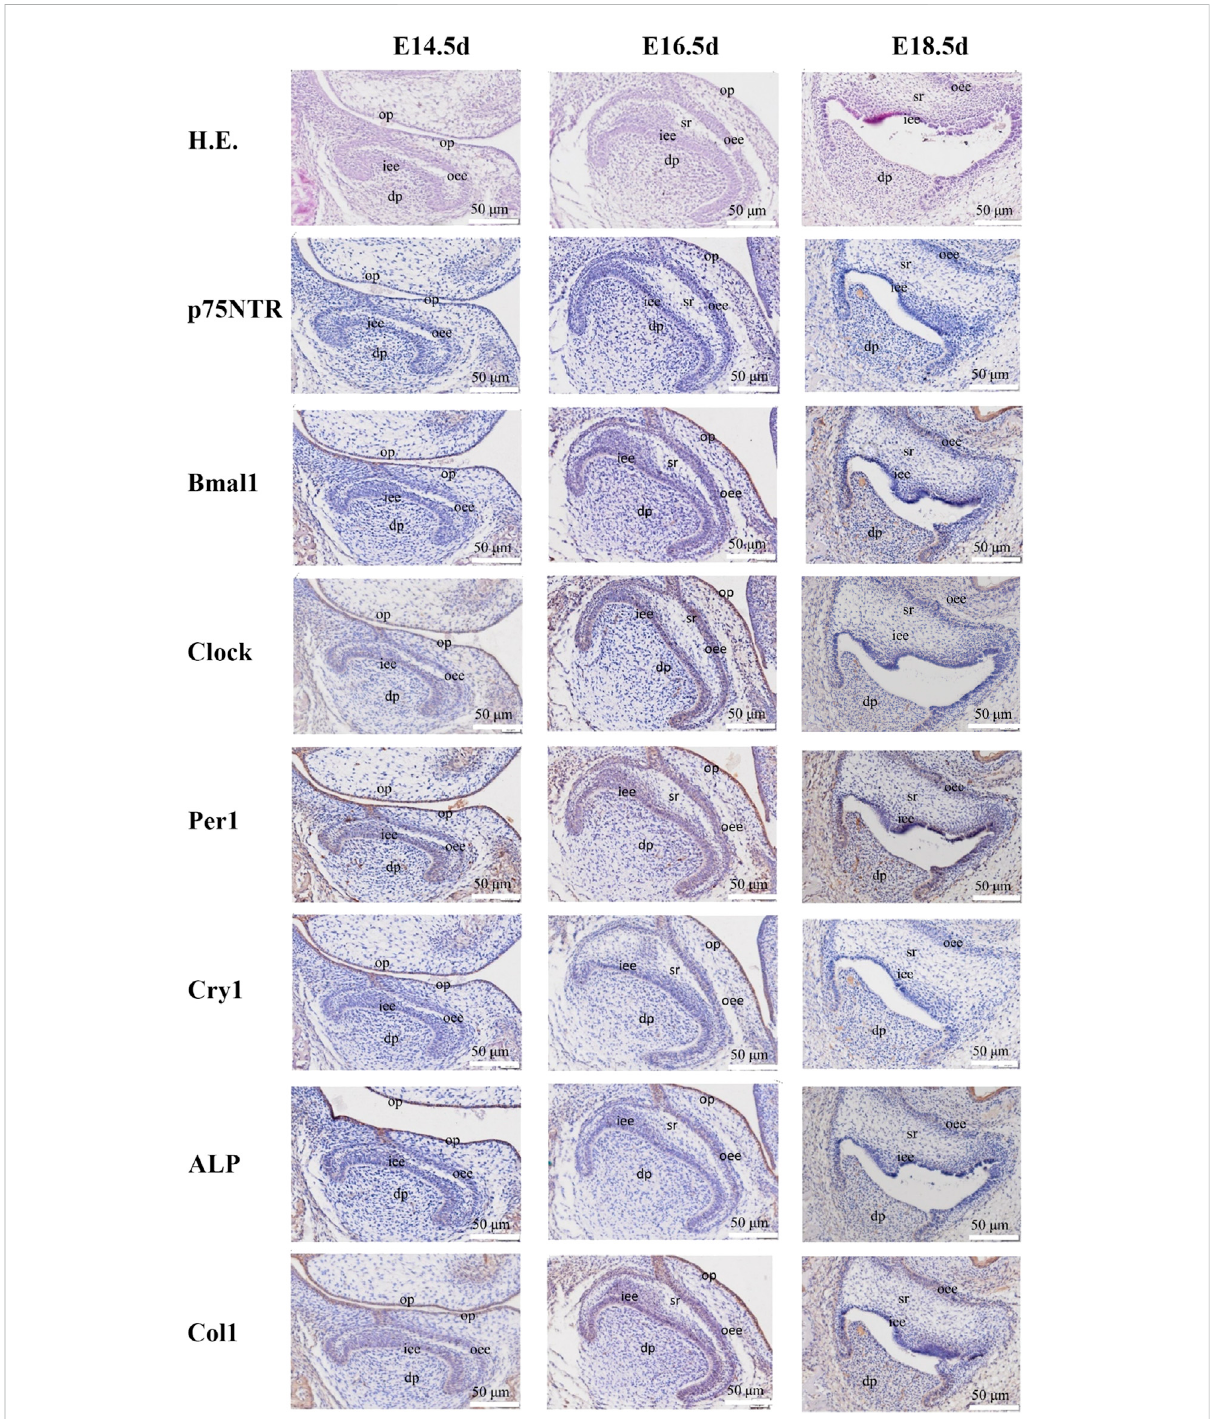
FIGURE 1 The images of H.E. staining and immunohistochemistry staining for prenatal rat dental germs. H.E. staining demonstrated that the rat dental germs entered the early cap stage at E14.5 d, the cap stage and early bell stage at E16.5 d, and the bell stage at E18.5 d. The separation between the pre-odontoblast and pre-ameloblast layers occurred in all E18.5 d species. Immunohistochemistry staining revealed that Clock , Per1 , and Col1 were detected in the epithelial-mesenchymal interaction area, dental follicle, and dental papilla at E14.5 d, and became stronger at E16.5 d when p75NTR , Bmal1 , and ALP were detected. All the factors were expressed at E18.5 d, but Cry1 showed the weakest expression. All experiments were repeated three times independently. o p : oral epithelium; dp: dental papilla; iee: inner enamel epithelium; oee: outer enamel epithelium; sr: stellate reticulum. The scale bar represents 50 μ m,